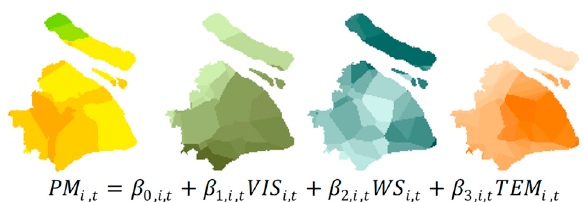
Figure 5. Illustration of the geographically weighted regression (GWR) model.